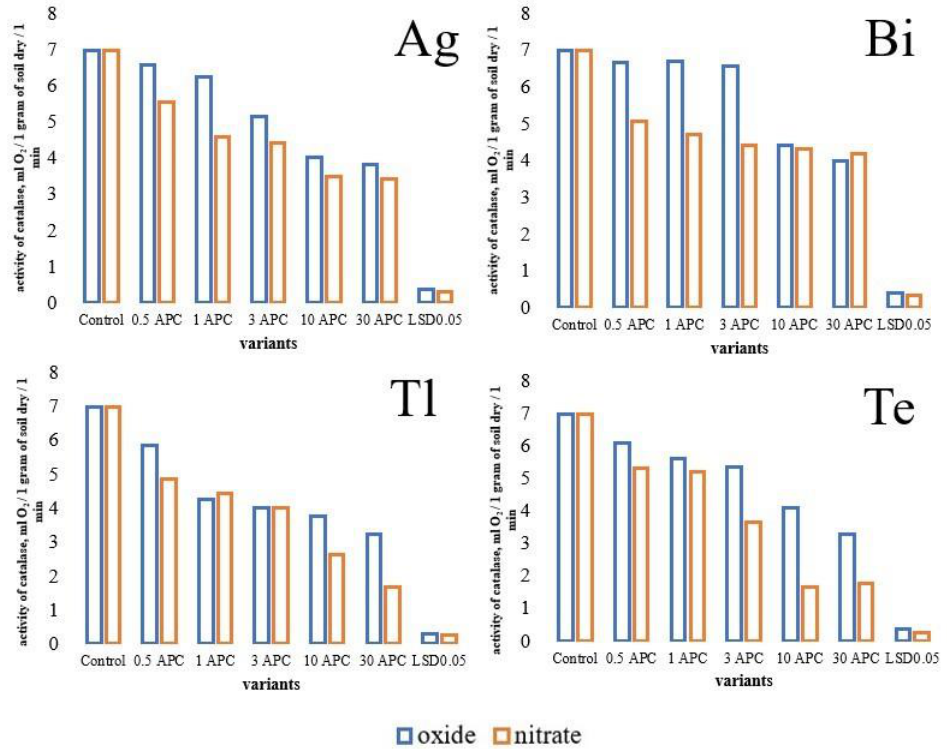
Figure 2. Changes in activity of catalase in haplic chernozem by contamination with oxides and nitrates of Ag, Bi, Tl, and Te, mL O 2/ 1 g of soil dry/1